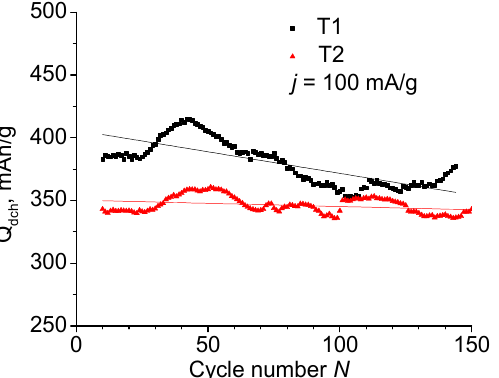
Figure 2. Discharge capacity of T1 and T2 anodes as a function of cycle number.